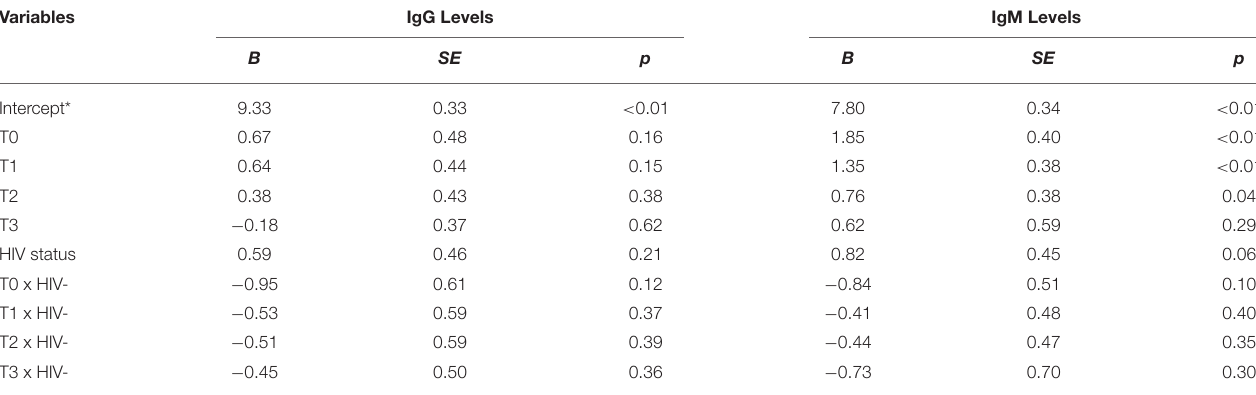
TABLE 2 | Time points predicting immunoglobin G (IgG) and immunoglobin M (IgM) to SARS-CoV-2 by HIV status.